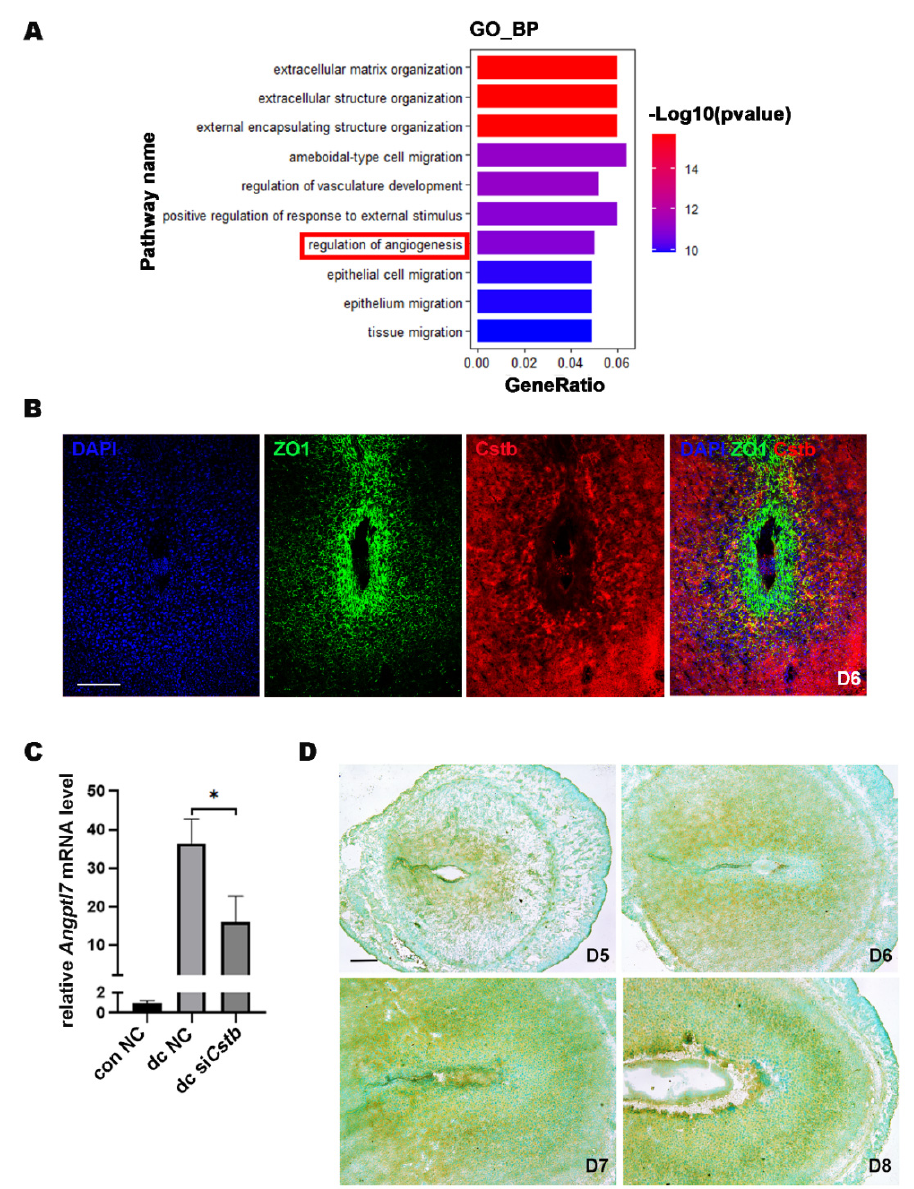
Figure 7. Cstb expression is associated with angiogenesis in mouse uterine stromal cells Angptl7 . ( A ) Gene ontology (GO) functional classification of the DEGs. ( B ) The expressions of Cstb and ZO1 were detected by immunofluorescence in the uterus on day 6. Bar = 300 µ m. ( C ) The expression of Angptl7 in stromal cells of the con NC group, dc NC group, and dc si Cstb group was detected by RT-qPCR. ( D ) The expression of Angptl7 in mouse uteri from days 5 to 8 of pregnancy was detected by in situ hybridization. Bar = 300 µ m. * p < 0.05. NC, negative control; si Cstb , siRNA of Cstb ; dc, in vitro decidualization.